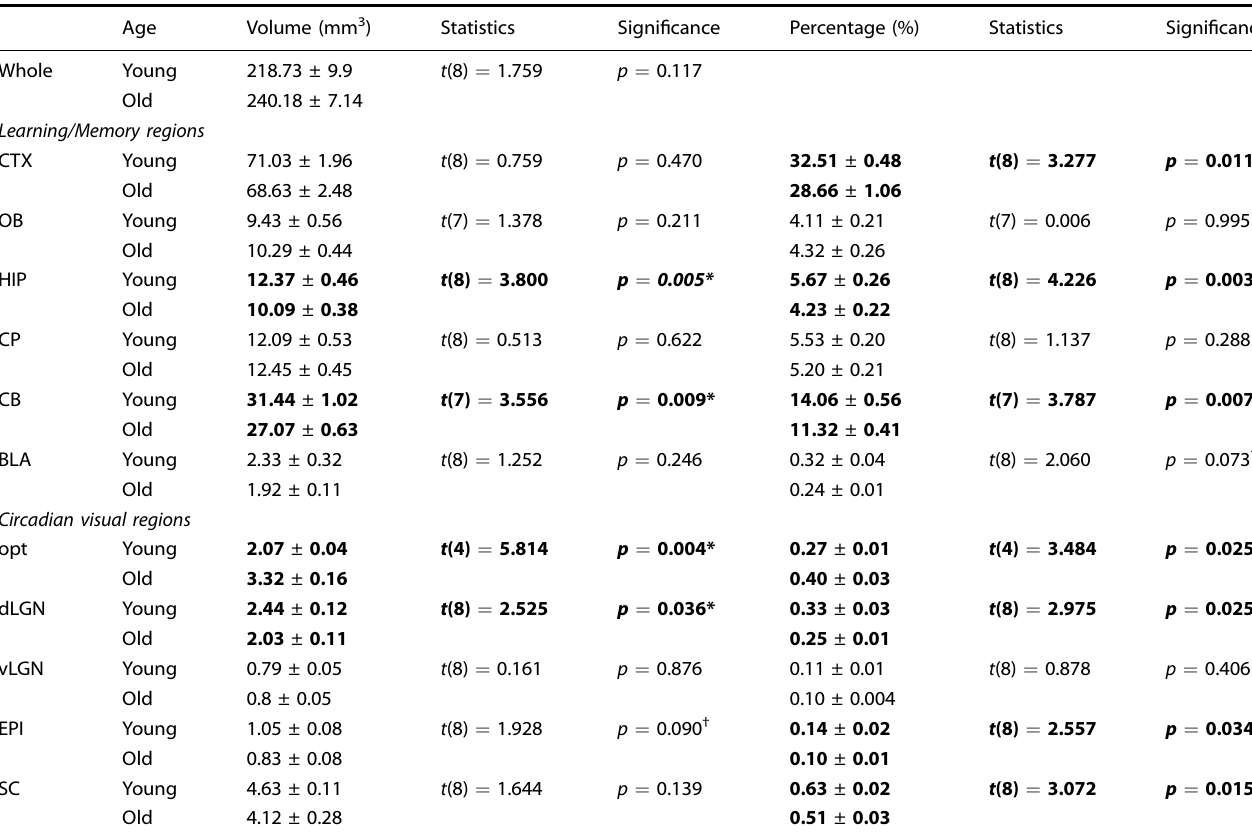
Table 2. Quanti fi cation of regions of interest MR